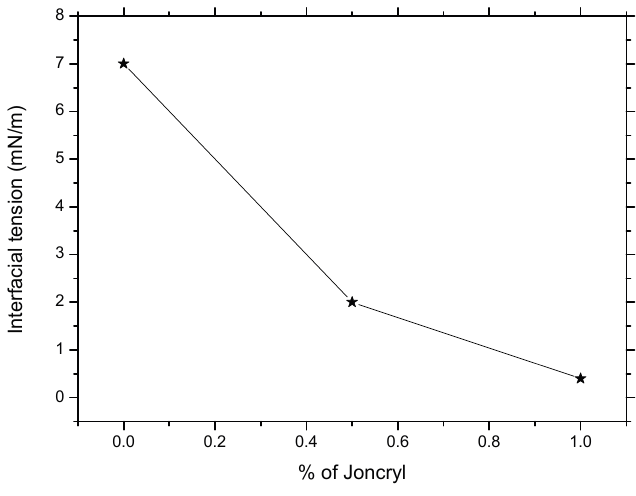
Figure 3. Evolution of the interfacial tension given by DDRM as a function of the Joncryl amount into PLA–PBAT